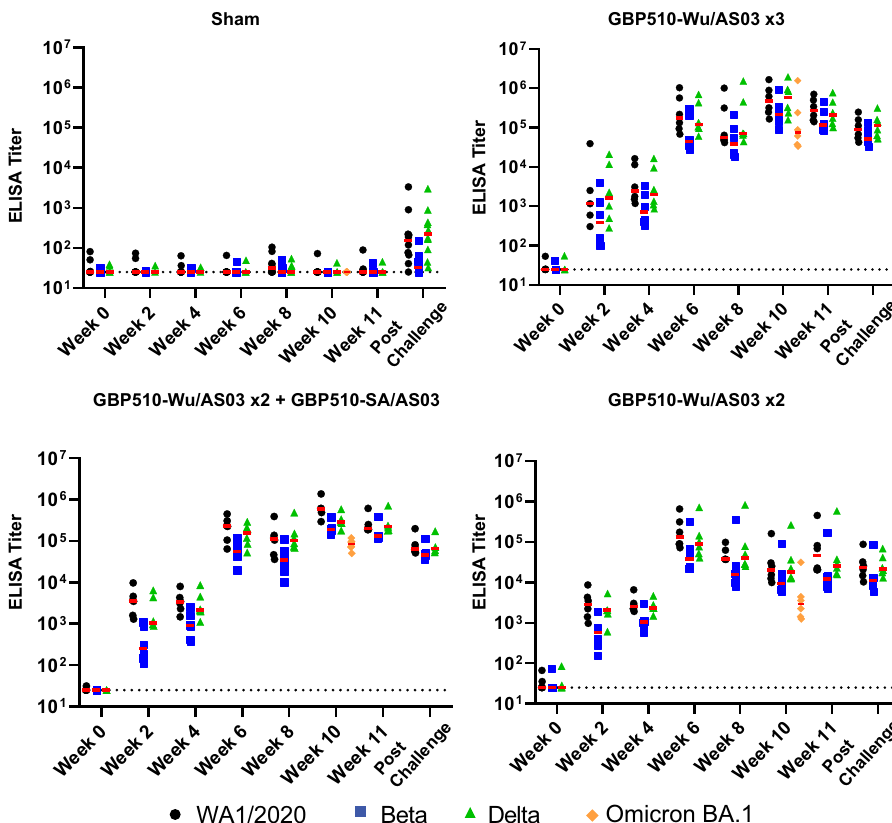
Fig. 3 Binding antibody responses measured to the vaccines. Antibody binding titers enzyme-linked immunosorbent assay (ELISA) for WA1/ 2020 RBD (black circles), Beta RBD (blue squares), and Delta RBD (green triangles). The limit of quantitation (EPT = 25) is represented by a dotted line. Medians are shown with red bars. Group 1 received three sham doses, Group 2 received three doses of GBP510-Wu, Group 3 received two doses of GBP510-Wu and one dose of GBP510-SA, and Group 4 received two doses of GBH510-Wu and one sham